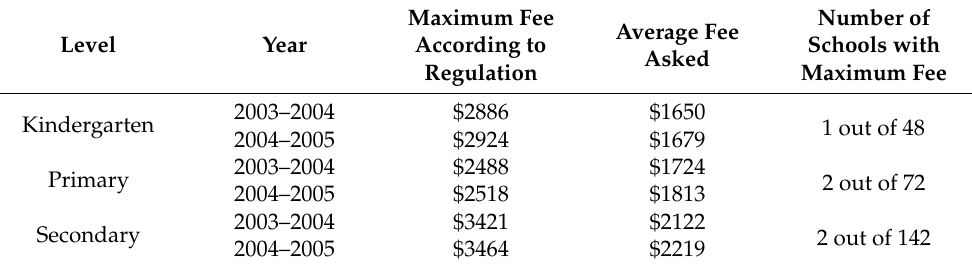
Table A4. Authorized and actual maximum schooling fees charged by Qu é bec’s independent schools, by education level, selected school years 2003–2004 and 2004–2005.